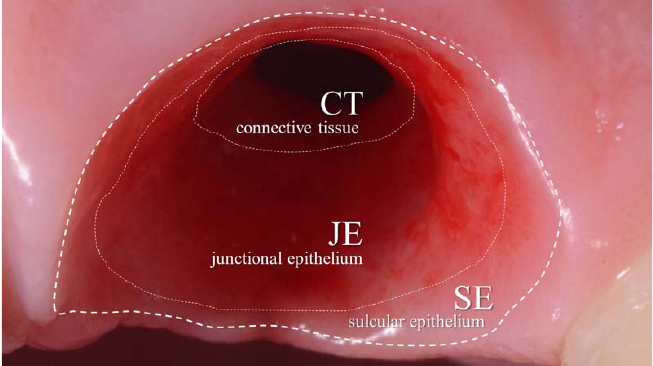
Figure 1. Peri-implant transition zone: connective tissue CT (1–1.5 mm) is directly connected to the peri-implant bone tissue. A junctional epithelium JE (1–2 mm) with a non-keratinized epithelium can be found above CT. A stratified squamous epithelium corresponding to the sulcular epithelium SE (1–1.5 mm) provides for the gingival margin area and is more superficial than both CT and JE, respectively.